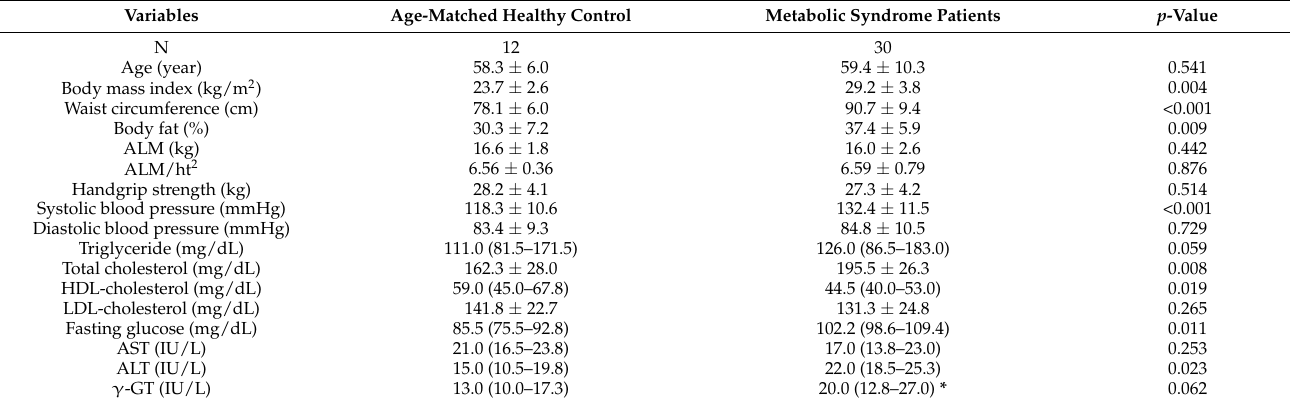
Table A1. Baseline demographic and clinical characteristics of the study participants.